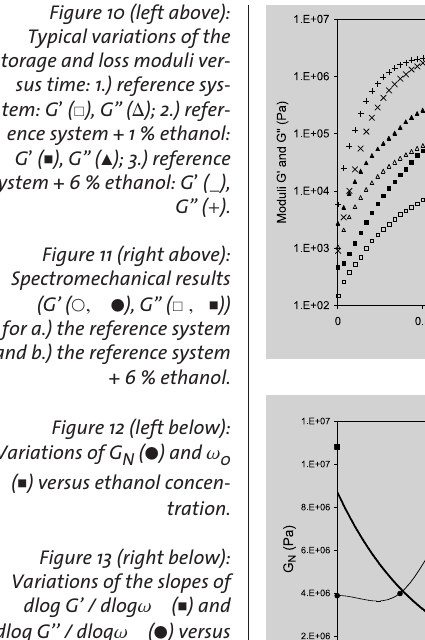
Figure 12 (left below): Variations of G N ( Ê ) and w 0 tration. Figure 13 (right below): Variations of the slopes of dlog G’ / dlog w ( ü ) and dlog G’’ / dlog w ( Ê ) versus ethanol weight